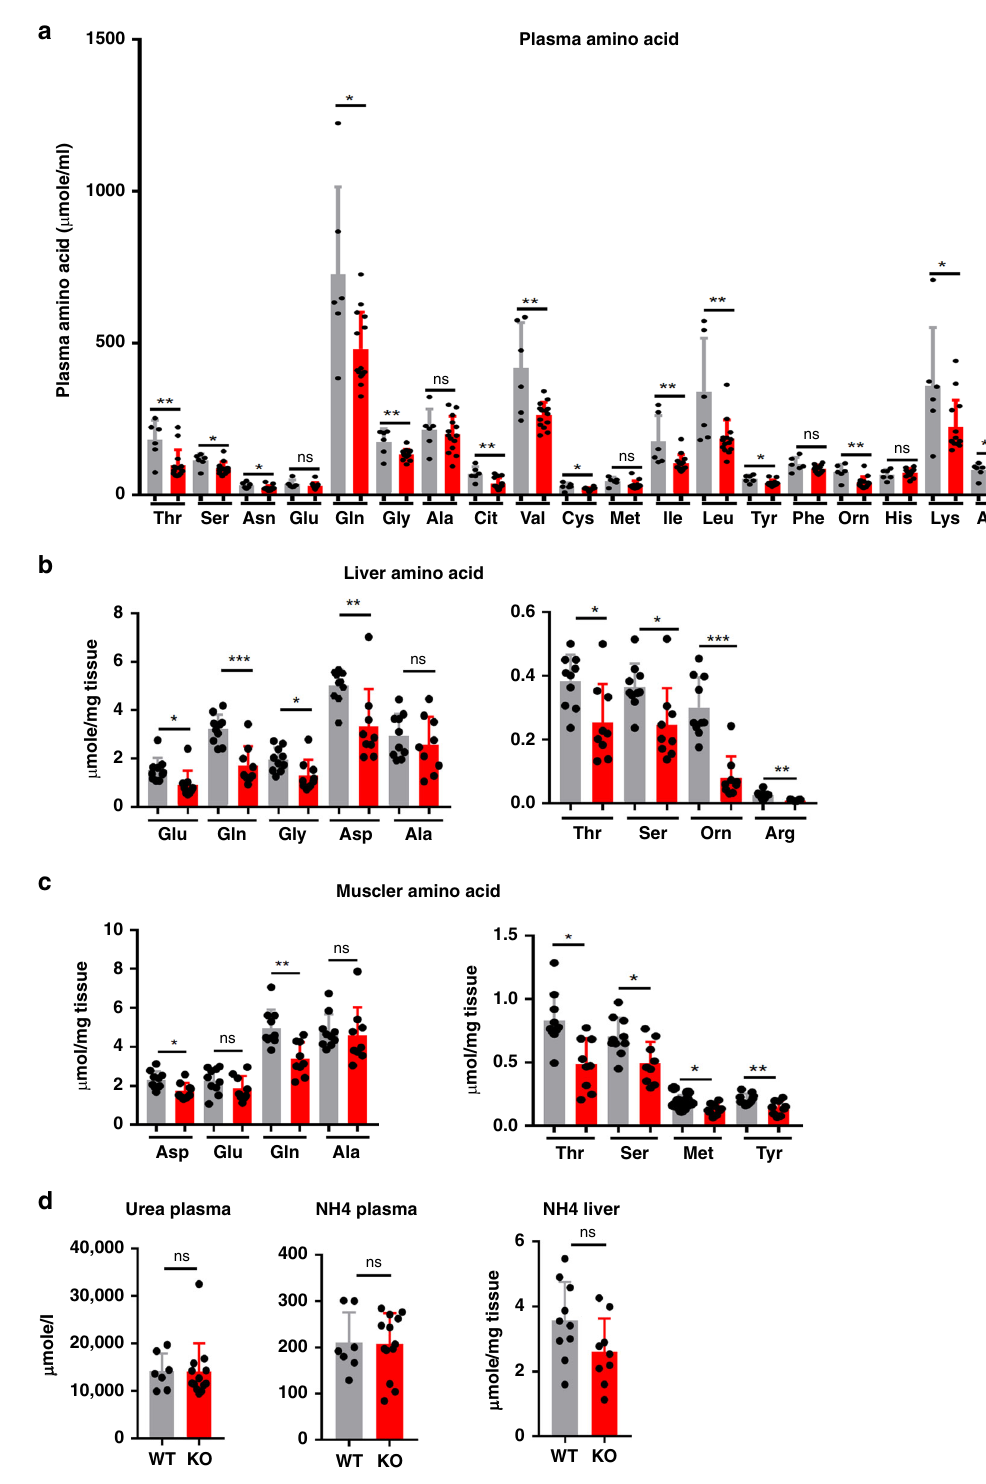
Fig. 5 Plasma, liver, and muscle amino acid content of Lkb1KO livad mice. a Plasma amino acid concentration in fasted mutant (KO: n = 13, red bar) and fasted control (WT: n = 7, gray bar) mice. b Hepatic amino acid content of fasted mutant mice (KO: n = 10, red bar) and fasted control mice (WT: n = 9, gray bar). c Muscle (tibialis) amino acid content of fasted mutant mice (KO: n = 10, red bar) and fasted control mice (WT: n = 9, gray bar). d Ammonia and urea level in the plasma and ammonia level in the liver of Lkb1KO livad (KO, n = 13, red bar) and controls (WT, n = 7, gray bar). All data are presented as mean values ± SD. P values were determined by unpaired two-tailed t -test. ns: not signi fi cant; * p ≤ 0.05; ** p ≤ 0.01; *** p ≤ 0.01. For all the experiments described in this fi gure, animals were analyzed 15 days after the injection of